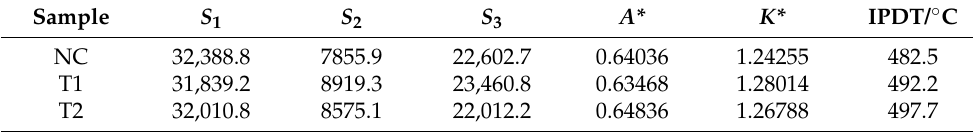
Figure 6. ( a ) TGA and ( b ) DTG curves of NC, T1 and T2 nanocomposites. Note: NC represents a nanocomposite with no compatibilizer, T1 represents a nanocomposite with MAH compatibilizer (MAH/GnP 1:1) prepared by the two-step method, and T2 represents a nanocomposite with MAH compatibilizer (MAH/GnP 1:1) and DCP via the one-pot method. Table 2. Effect of MAH on the thermal stabilities of the conductive nanocomposite system.